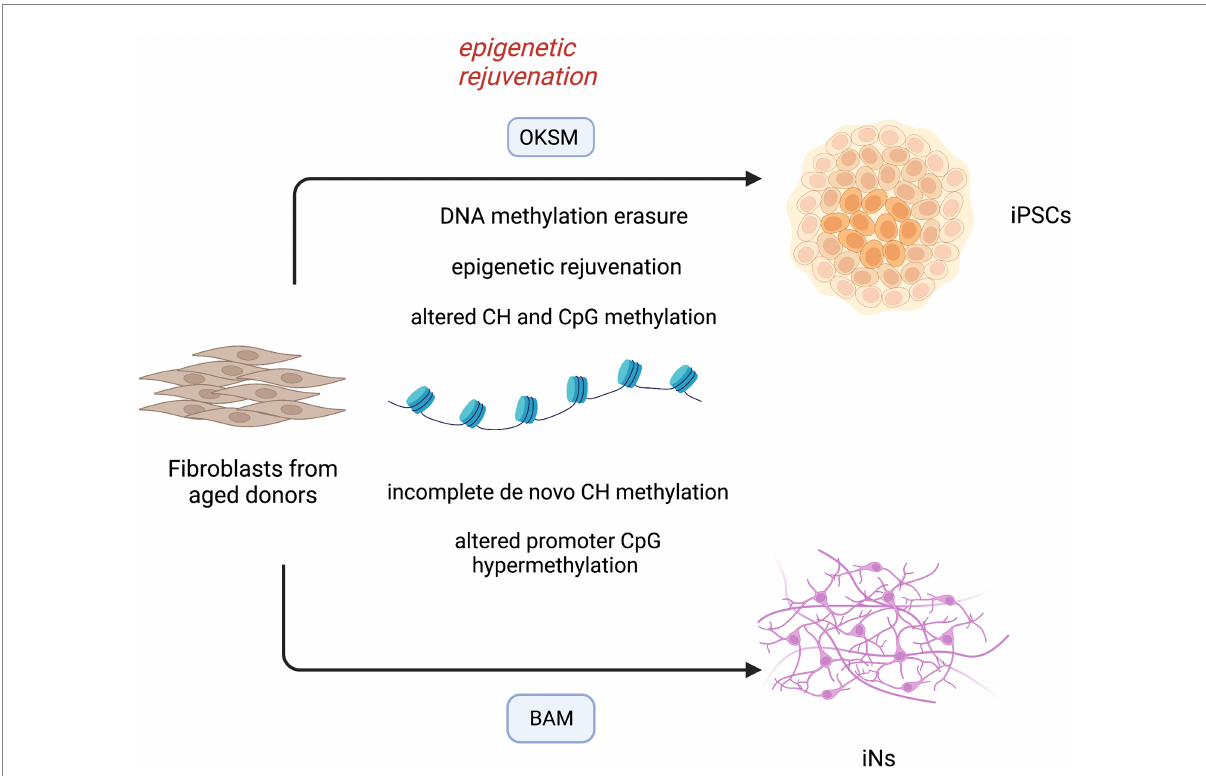
FIGURE 2 DNA methylation landscape in induced-pluripotent stem cells (iPSCs) and directly converted neurons (iNs). Reprogramming of aged fibroblasts to the pluripotent cell stage is characterized by methylation erasure and reset of epigenetic clock. The epigenetic rejuvenation occurs before complete dedifferentiation to iPSCs, suggesting novel treatments for age-associated diseases. During this process, a large reconfiguration of DNA methylation leads to aberrant CH and CpG methylation in differentiated cells. iNs derived from aged fibroblasts bypass the intermediate pluripotent cell stage, but still lack a faithful CH DNA methylation and show an altered CpG hypermethylation pattern at promoter regions. OKSM (OCT4, KLF4, SOX2, C-MYC); BAM (ASCL1, BRN2,